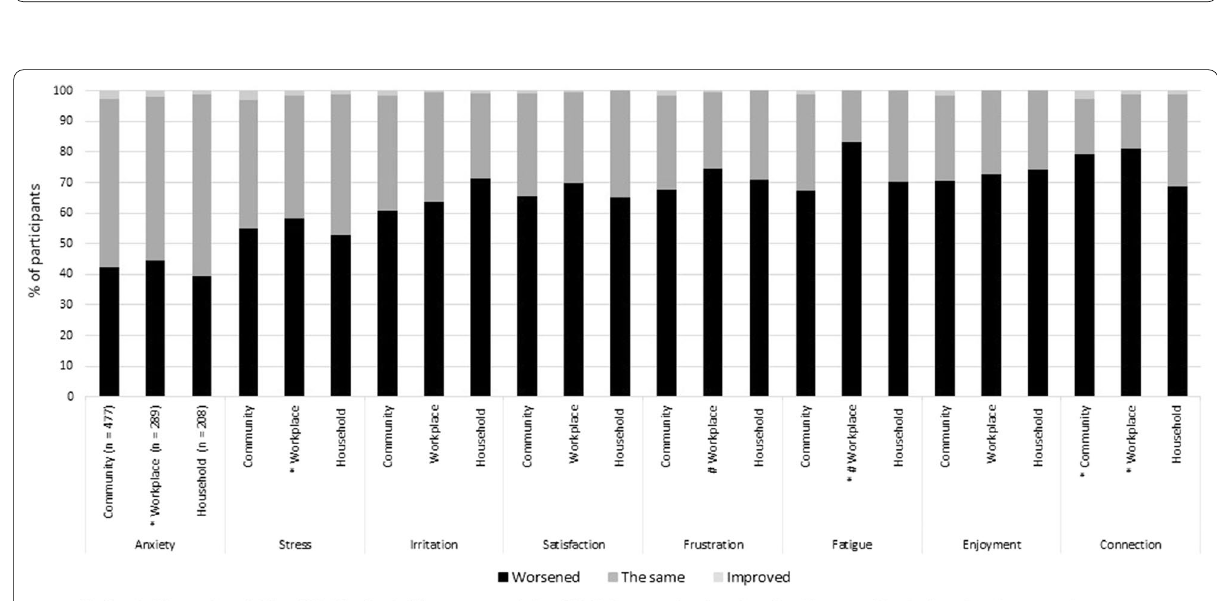
Fig. 3 Percentage of participants reporting face mask use by other people was very or somewhat influential on feelings related to communication who reported a worsened, the same, or improved impact on eight feelings when communicating in the community ( n ( n 289), and with household members ( n = =